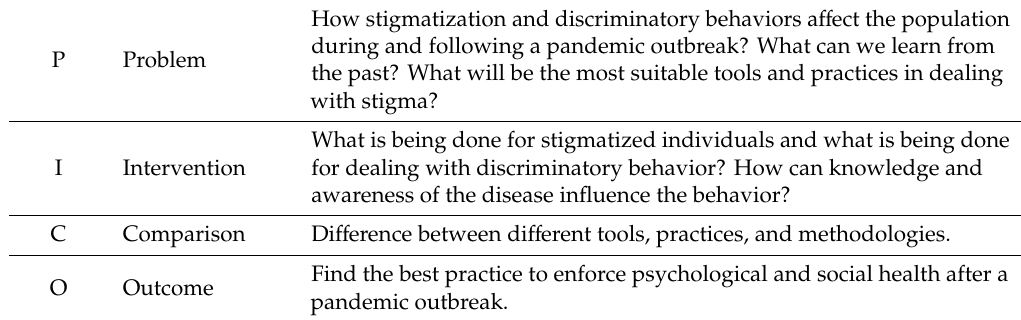
Table 1. Problem, Intervention, Comparison, Outcome (PICO) research